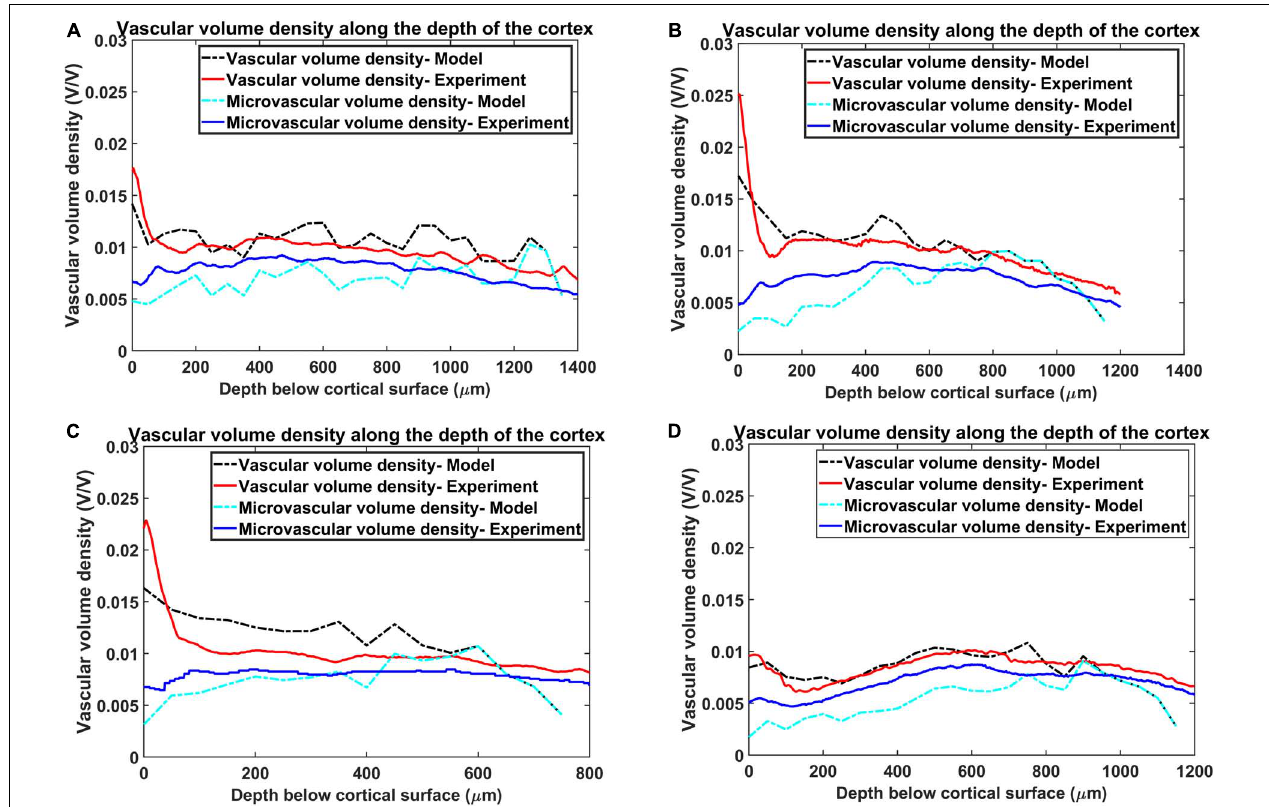
FIGURE 8 | Estimation of vascular volume density and microvascular volume density from all the four regions. The red plot and the blue plot shows the experimentally observed total vasccular volume density and microvascular volume density respectively. The black and the cyan plots trace the values of total vascular volume density and microvascular volume density as simulated by the model. The four regions are, (A) agranular cortex which was measured 1 mm anteroposterior and 1 mm mediolateral of the Bregma, (B) partially granular cortex measured –1 mm anteroposterior and 1 mm mediolateral of the Bregma, (C) partially granular cortex measured 2 mm anteroposterior and 1 mm mediolateral of the Bregma, and (D) granular cortex measured 1 mm anteroposterior and 4 mm mediolateral of the Bregma.